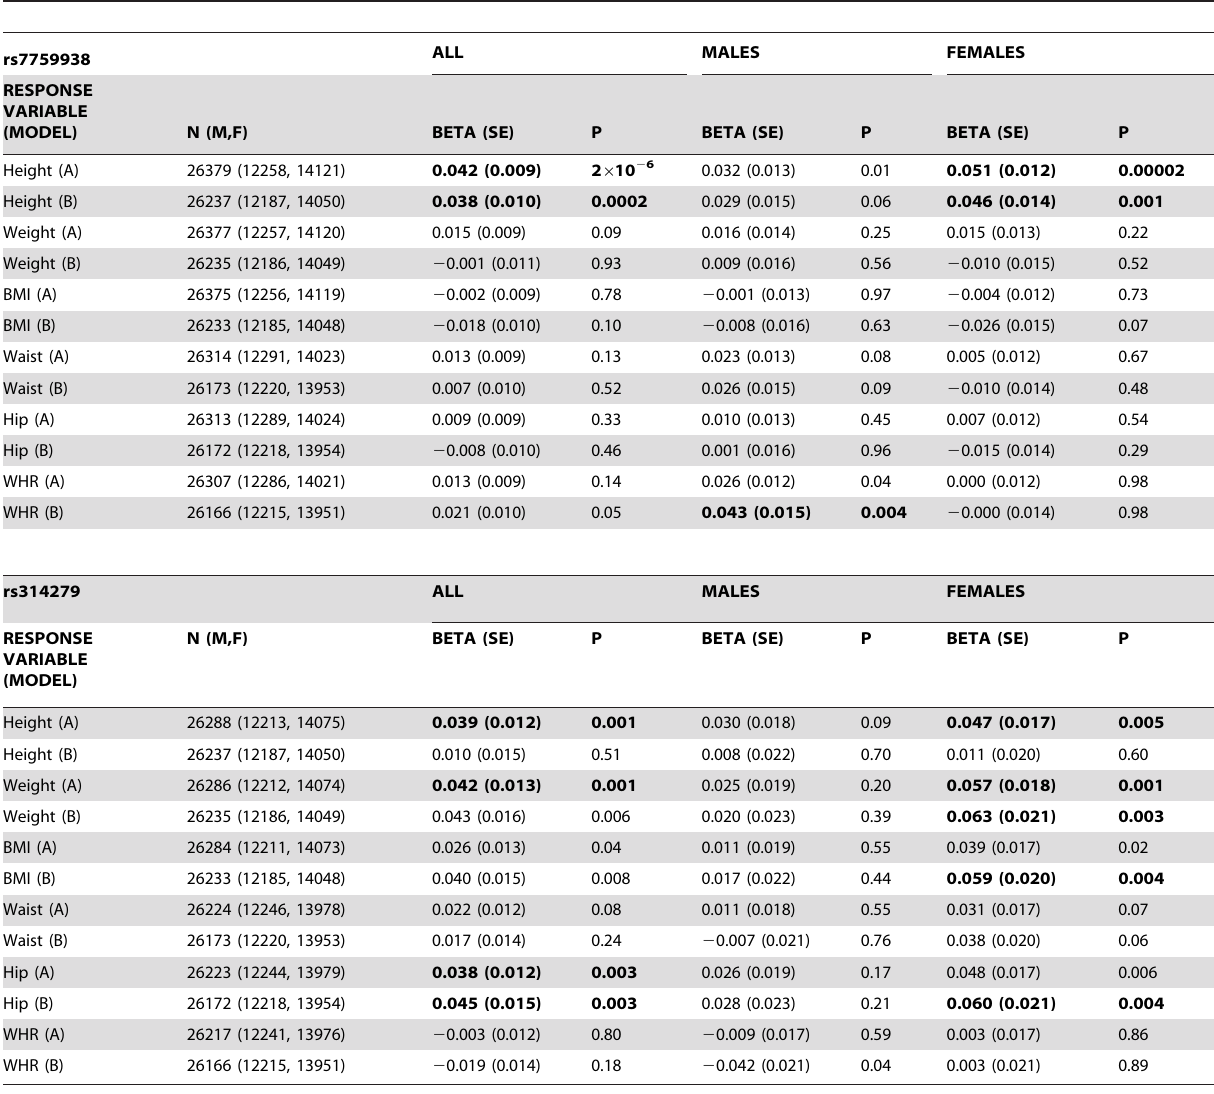
Table 1. Association of genetic variants rs7759938 (upper panel) and rs314279 (lower panel) with adult anthropometric traits.